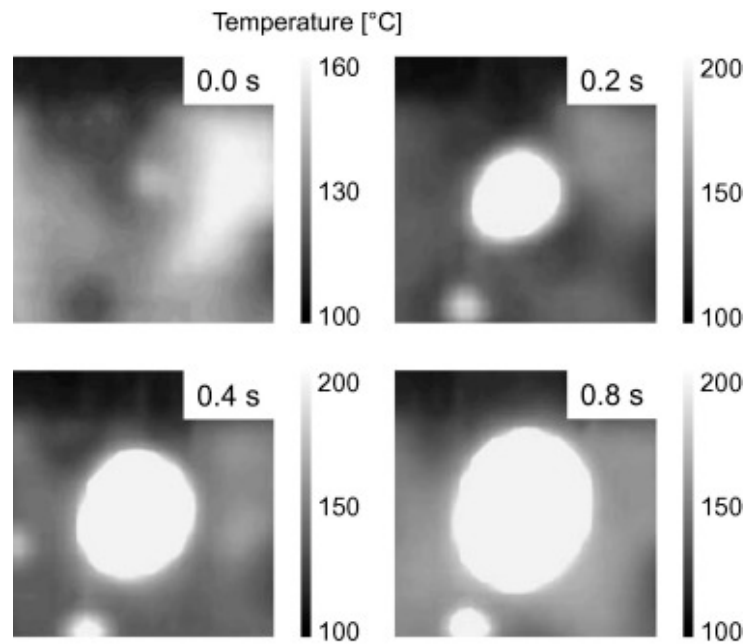
Figure 16. Demonstration of dry-spot development at CHF for water. Reproduced from [253], Elsevier: 2002.